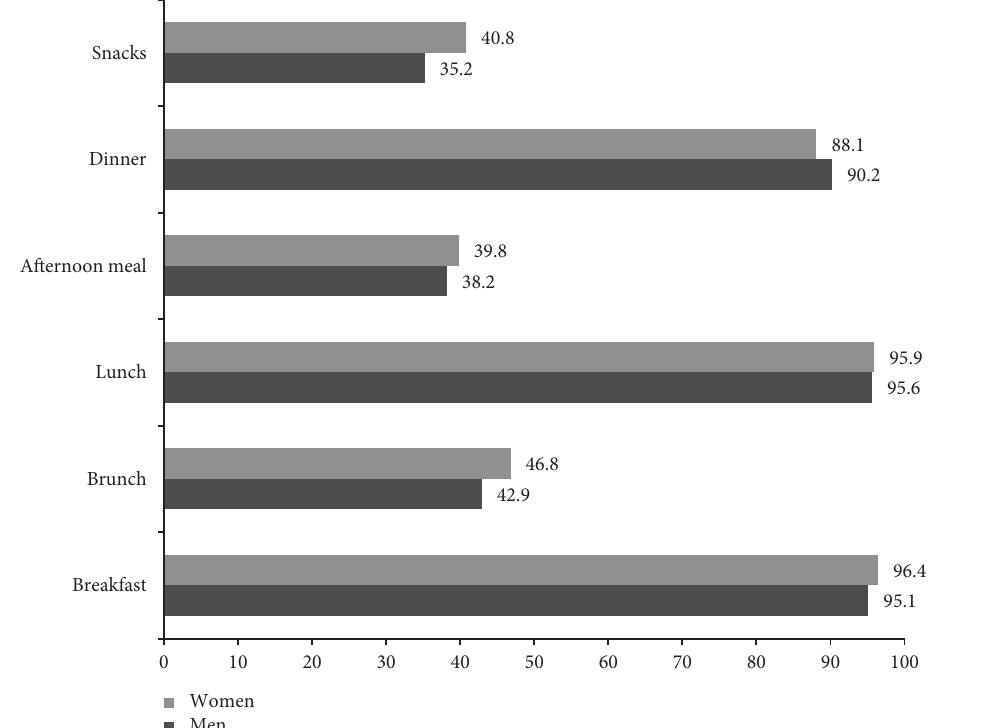
Figure 1: Frequency of eating patterns during social isolation.